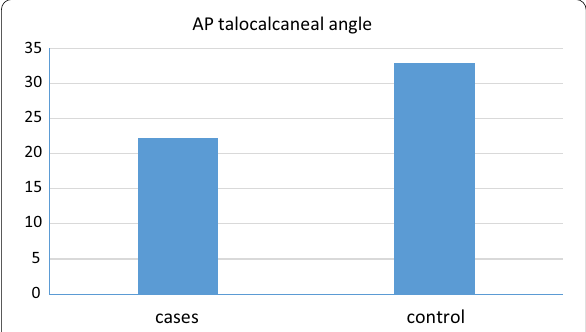
Fig. 1 Correlation of the AP talocalcaneal angles measured in X-rays between patients and